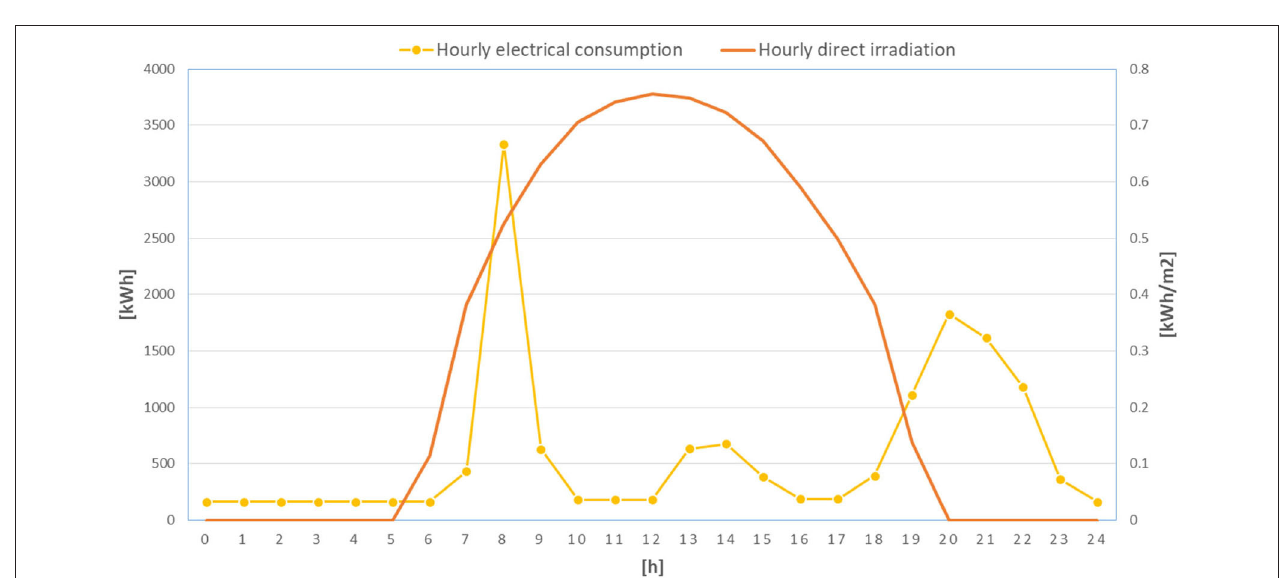
FIGURE 4 | Hourly electrical consumption of the area [kWh] and hourly direct irradiation [kWh/m 2 ].